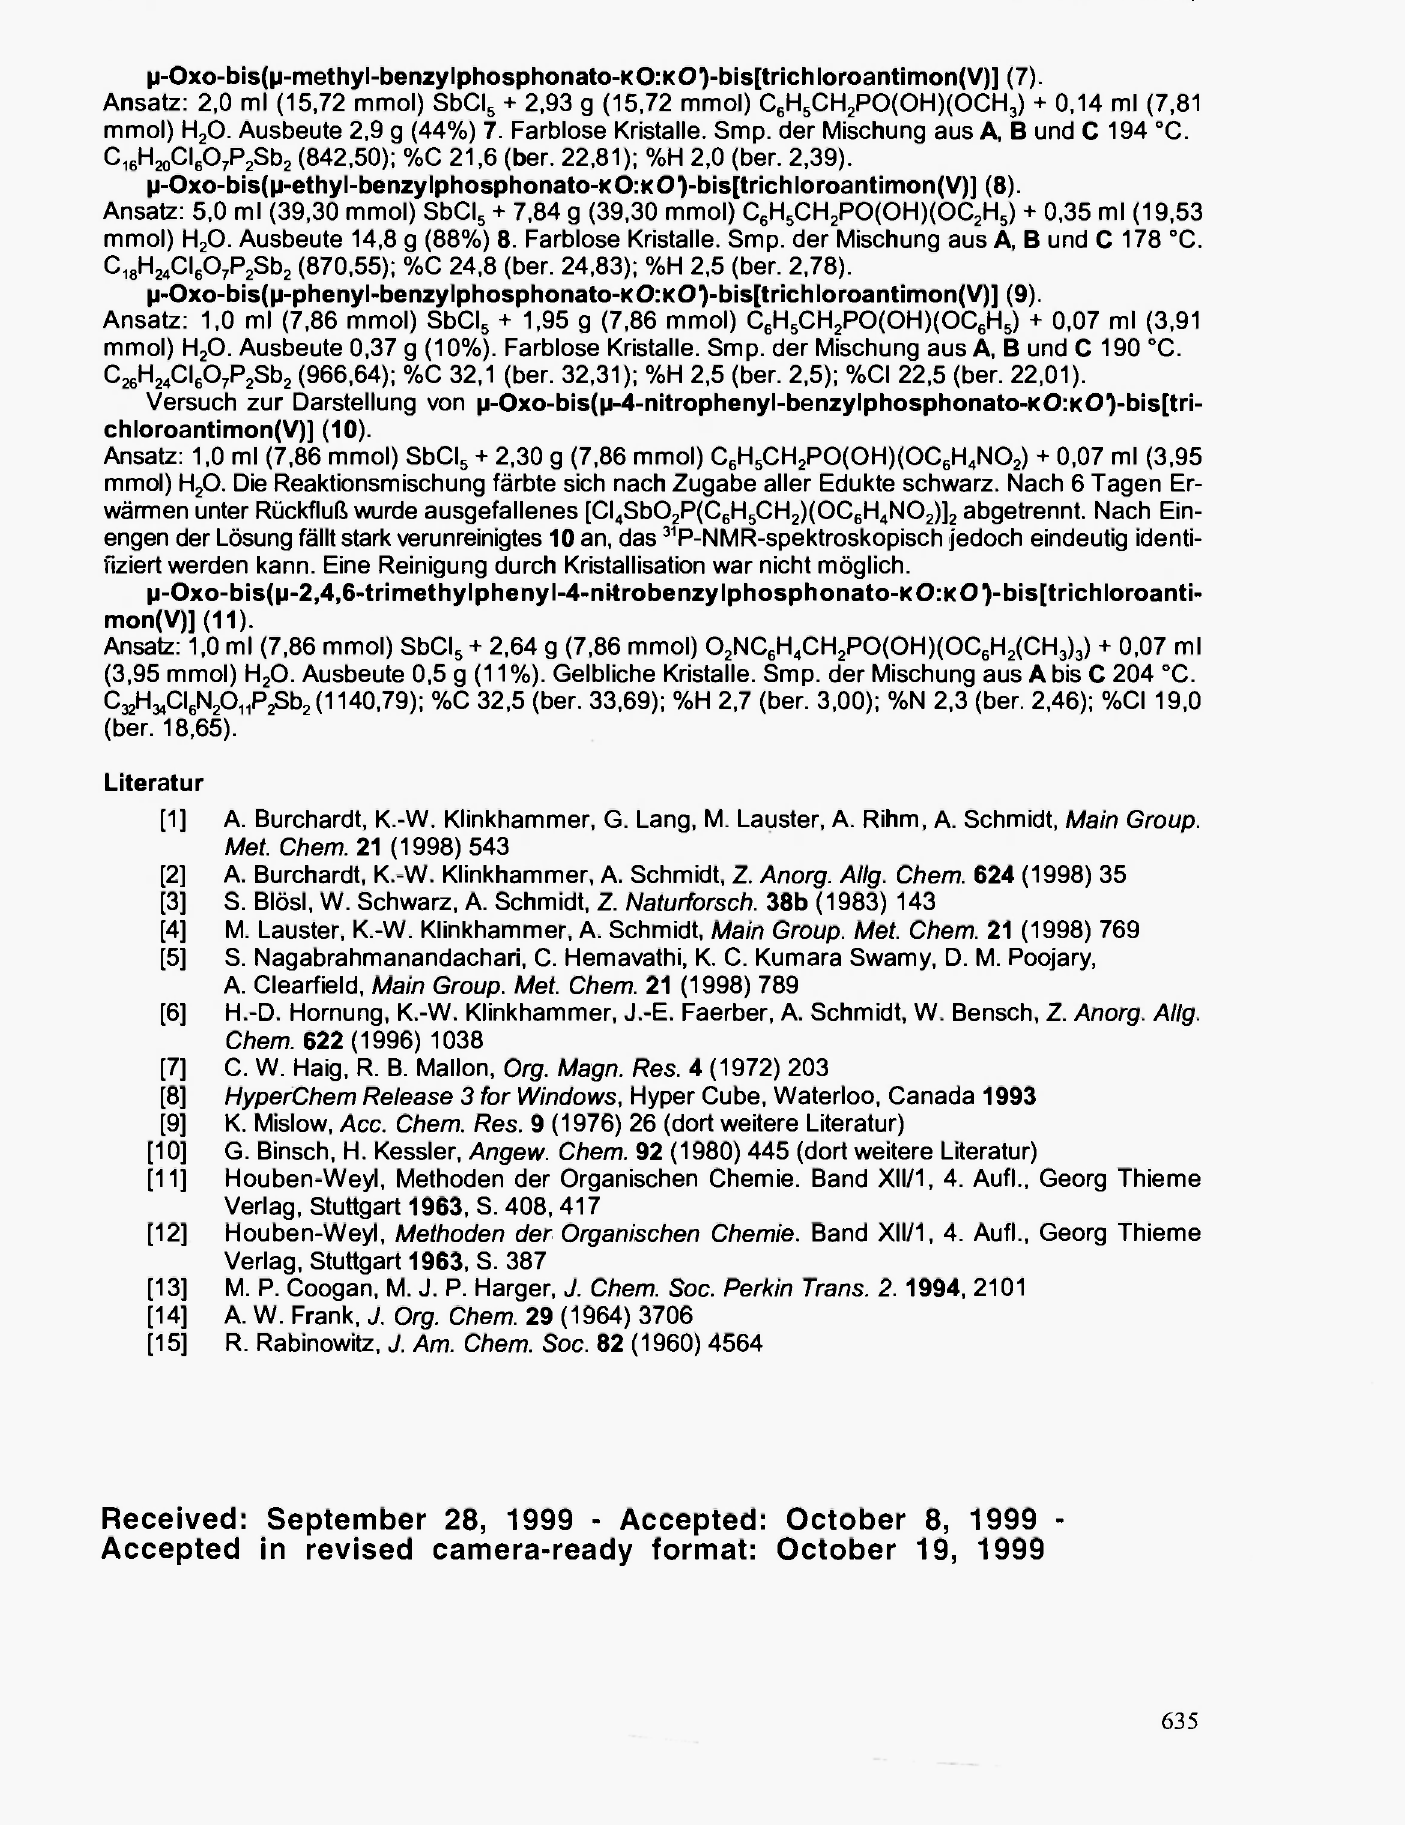
abgetrennt. Nach Ein-